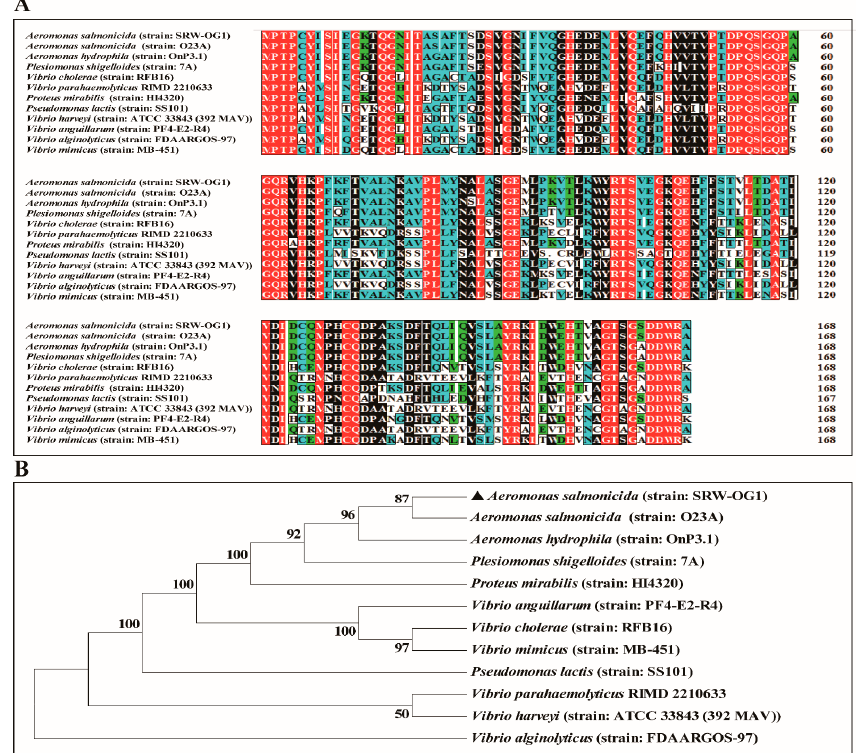
Figure 1. Phylogenetic tree and sequence alignment of the amino acid sequence of the hcp gene. ( A ) Amino acid sequence alignment. ( B ) Phylogenetic tree. Note: numbers at each branch indicate the percentage bootstrap values on 1000 replicates.